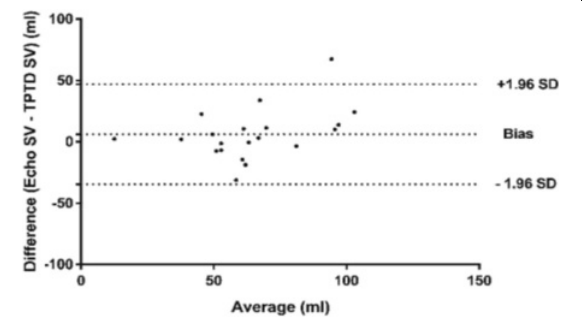
Fig. 76 (abstract A179). Bland-Altman plot of the differences between Echocardiography & TIPD SV against their